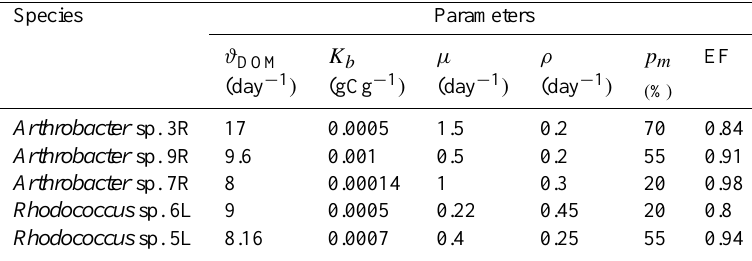
Table 1. Parameter values estimated by the calibration of MOSAIC II from carbon mineralization curves registered from incubation of each species with fructose at high water content (where ϑ DOM is the maximum growth rate, K b is the constant of half-saturation, µ is the mortality, ρ is the respiration, p m is the proportion of MB that returns to DOM) with their respective efficiency coefficients. Species